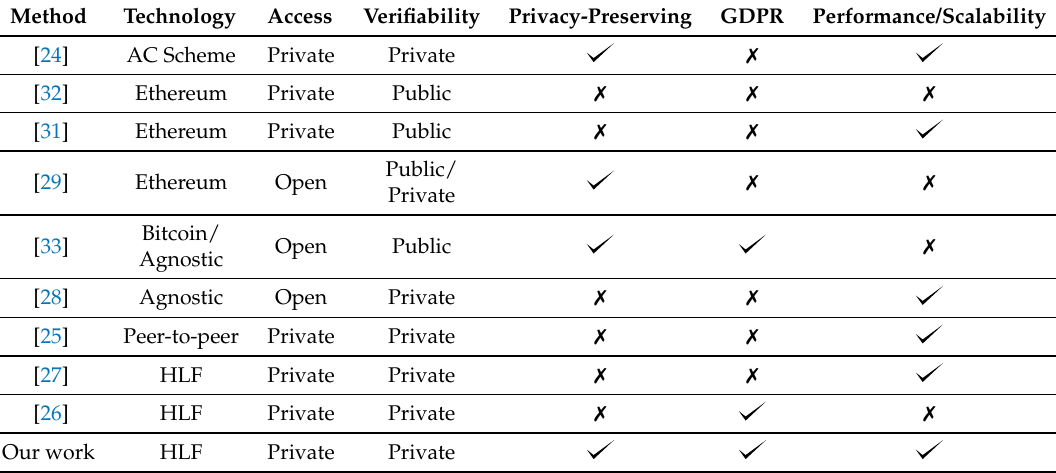
Table 1. Comparison of related